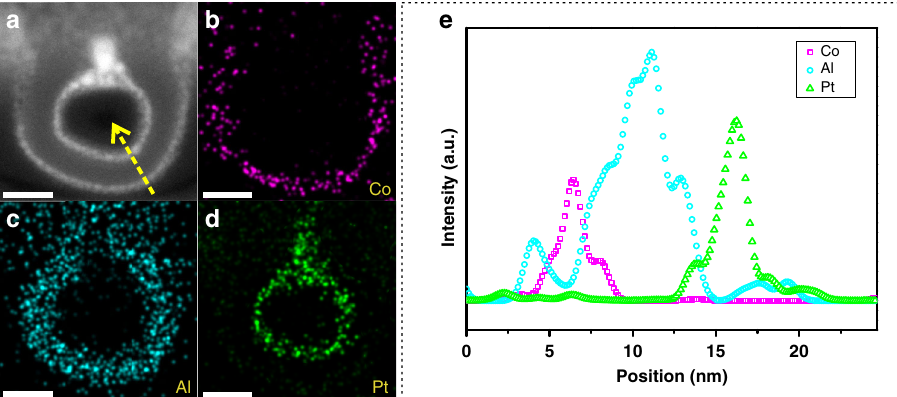
Fig. 2 Structural characterization of CoO x /50Al 2 O 3 /Pt. a STEM image (scale bar, 20 nm) and b – d EDX elemental mappings (scale bar, 20 nm) of a cross- sectional specimen of CoO x /50Al 2 O 3 /Pt prepared by focused ion beam milling. e Compositional point pro fi le of Co, Al, and Pt from the specimen recorded along the yellow arrow shown in a .